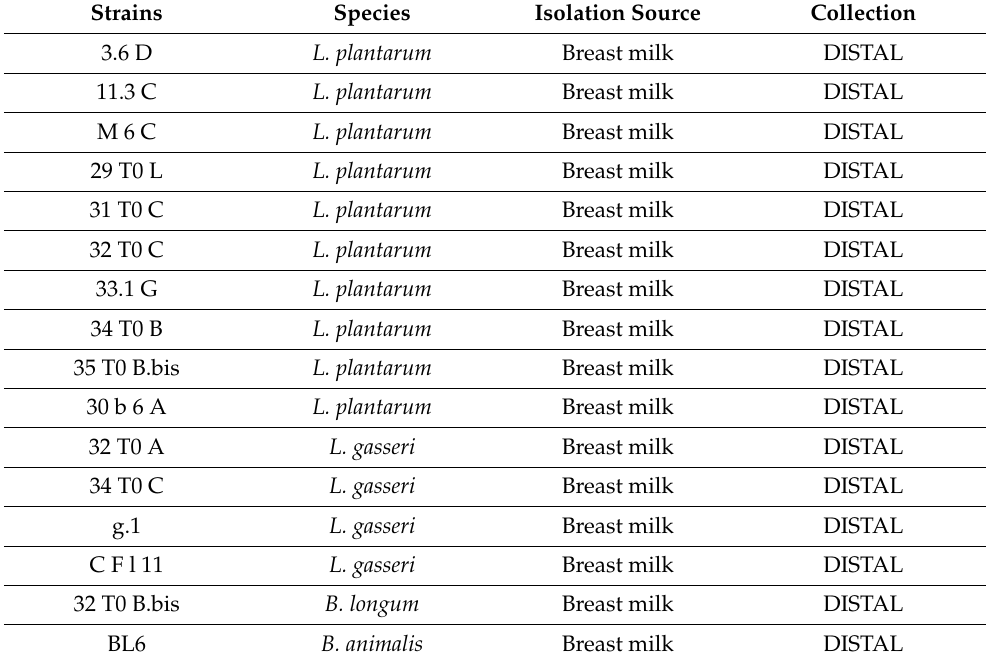
Table 1. Lactiplantibacillus, Lactobacillus and Bifidobacterium strains isolated from human breast milk and used in the present